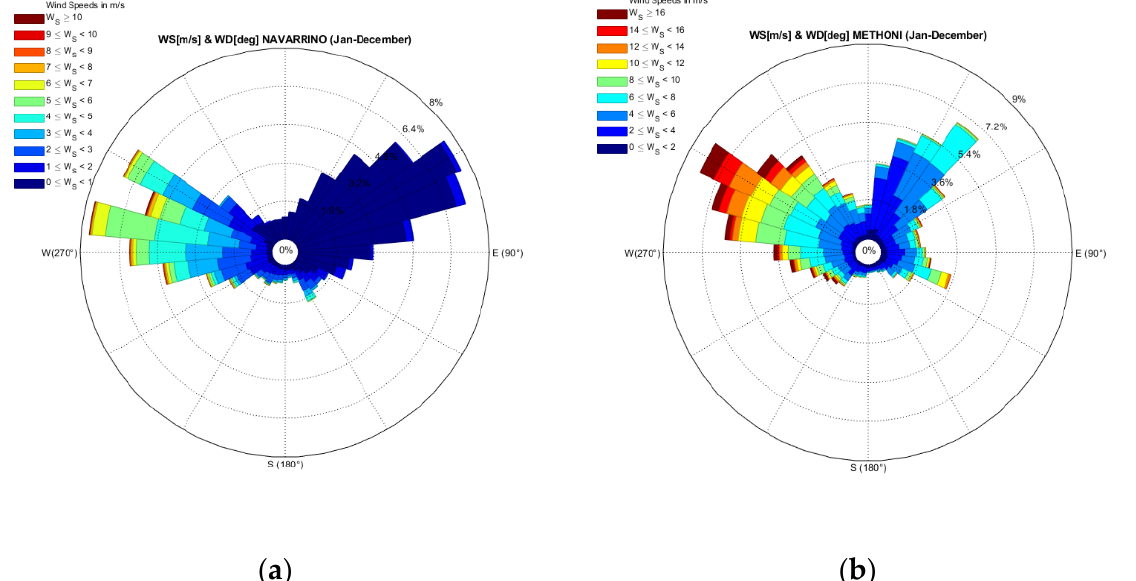
Figure 3. ( a , b ) a/Local wind roses for Navarino (left panel) and b/Methoni (right panel). Navarino 2011–2013 and Methoni 2014–2016.